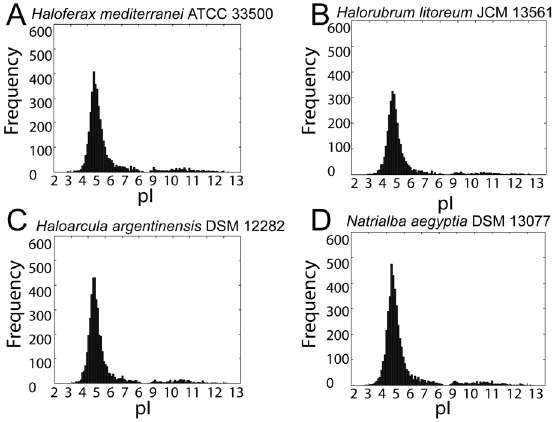
Figure 5. Proteome-wide isoelectric point distributions. Histo- grams of computed pI values for (A) Haloferax mediterranei , (B) Halorubrum litoreum , (C) Haloarcula argentinensis , and (D) Natrialba aegyptia . Each of these four species is a representative from the four most populous genera in the set, which collectively contain 66% of the organisms in the study. For all sequenced haloarchaea, the pI histograms exhibited a bimodal distribution with a major mode at about 4.5 and much smaller minor mode around 10. For all isoelectric point plots see Data Dryad package [67].